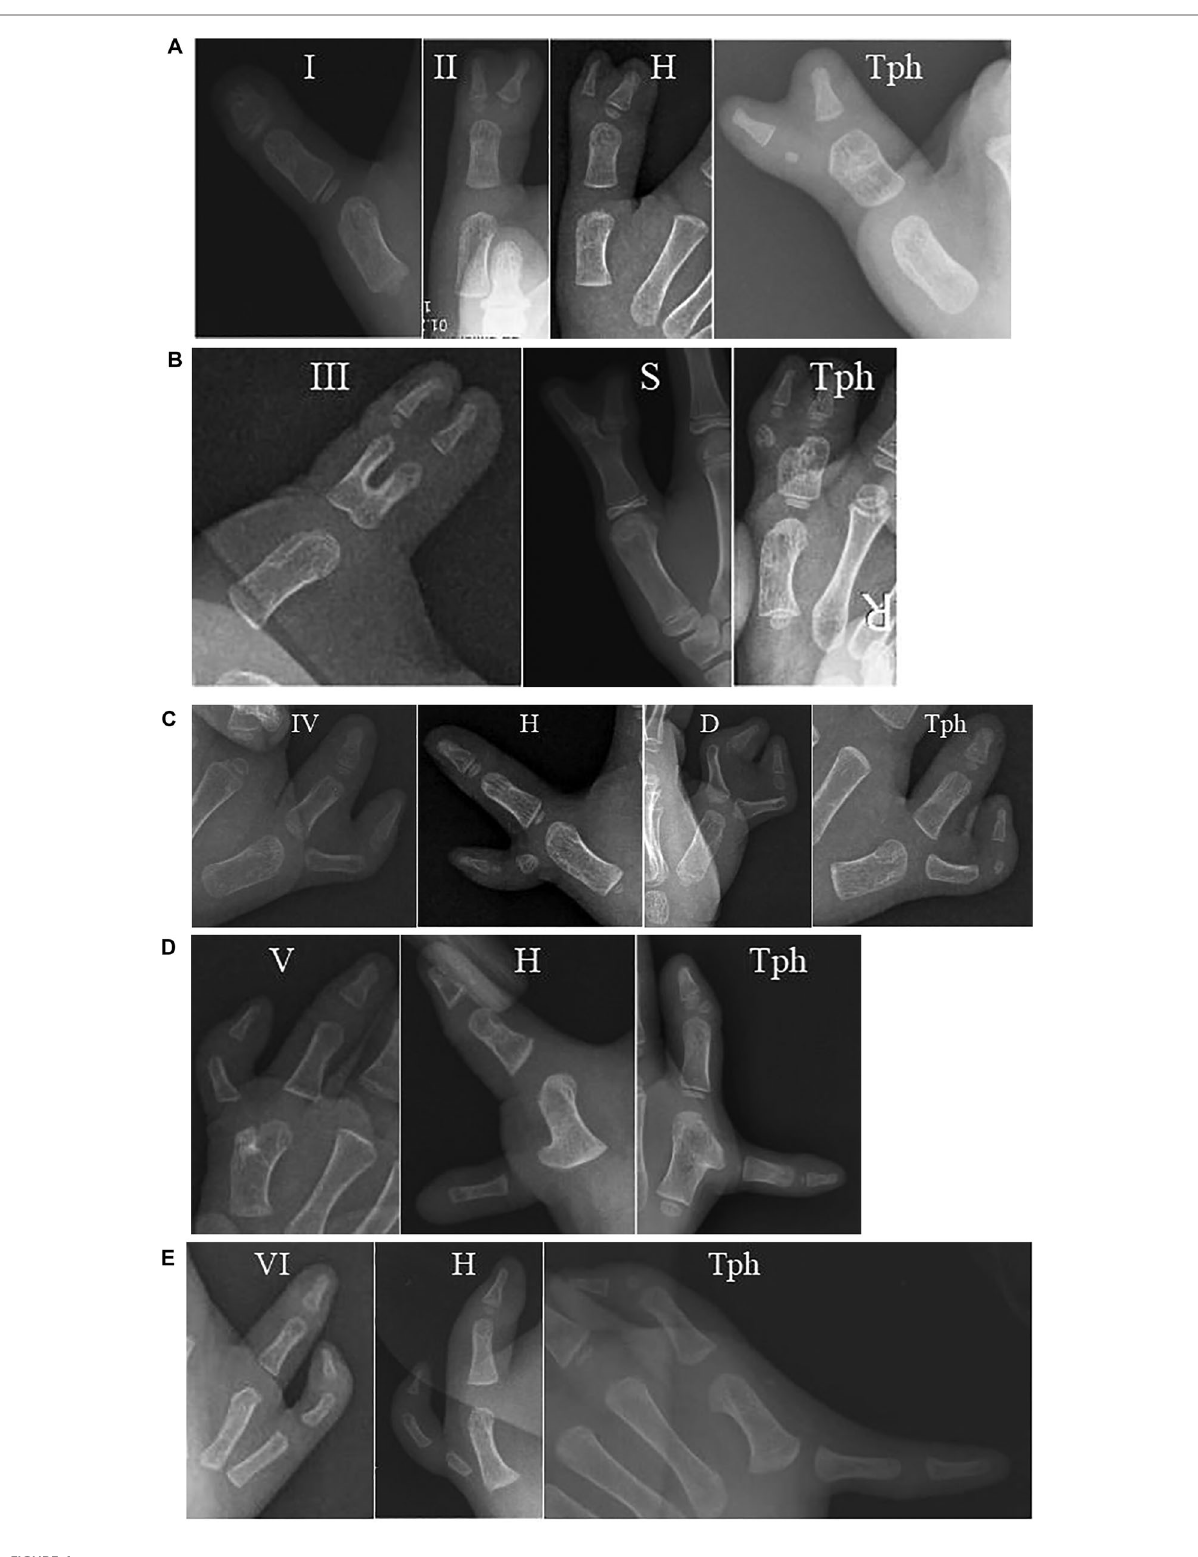
FIGURE 4 ( A – E) Radiograph of the Rotterdam Classi fi cation. ( A ) type I, II-II, II-H and II-Tph; ( B ) type III-III, III-S and III-Tph; ( C ) type IV-IV, IV-H, IV-D and IV-Tph; ( D ) type V-V, V-H and V-Tph; ( E ) type VI-VI, VI-H and VI-Tph. H, hypoplastic or fl oating; D, deviation; Tph, triphalangism; S,